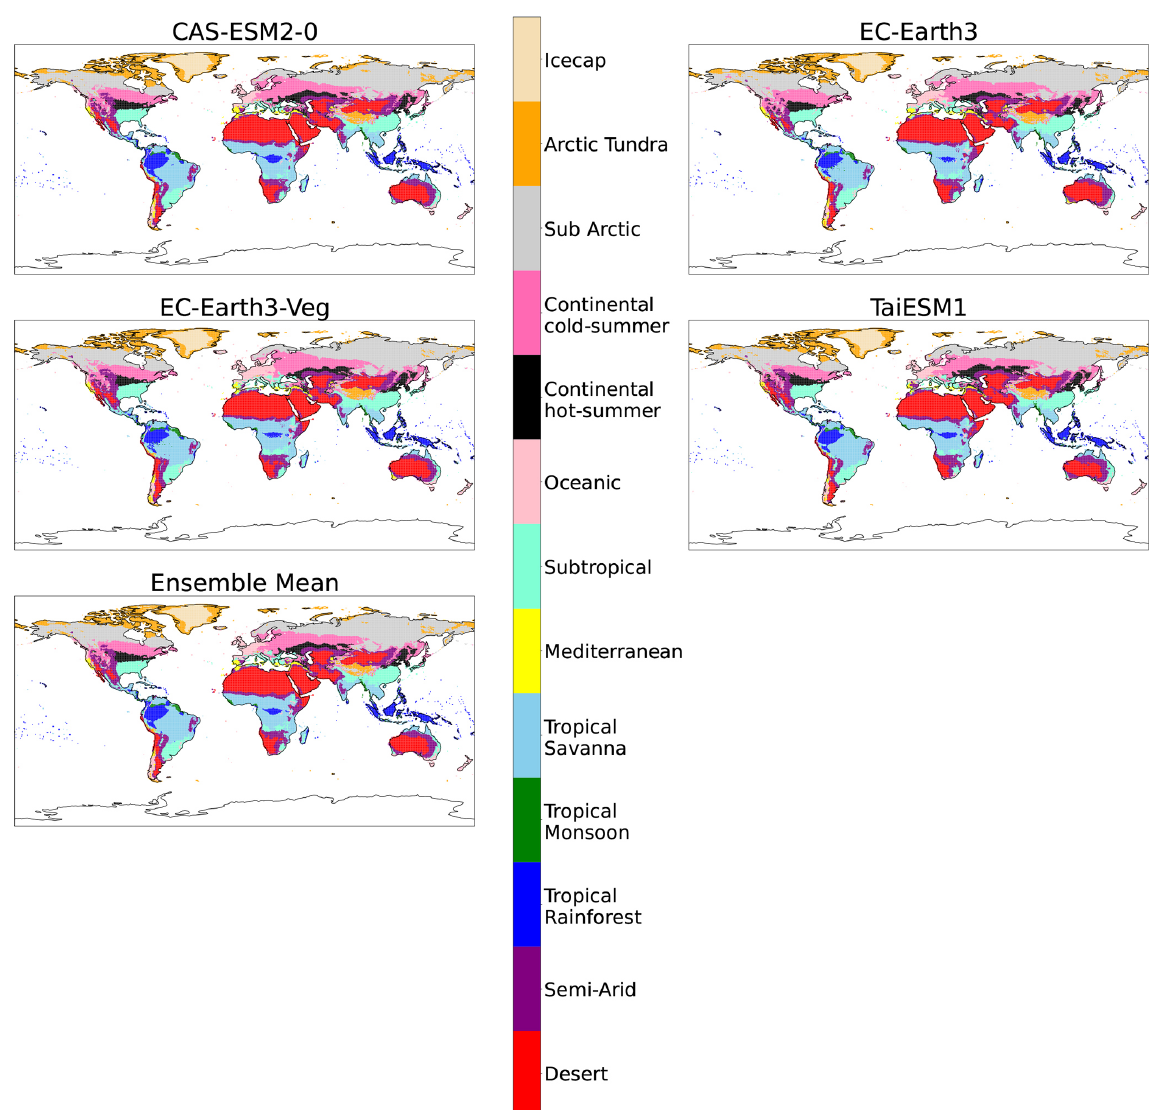
Figure B2. Maps of streamlined KG classifications for each model at + 1K with anomaly